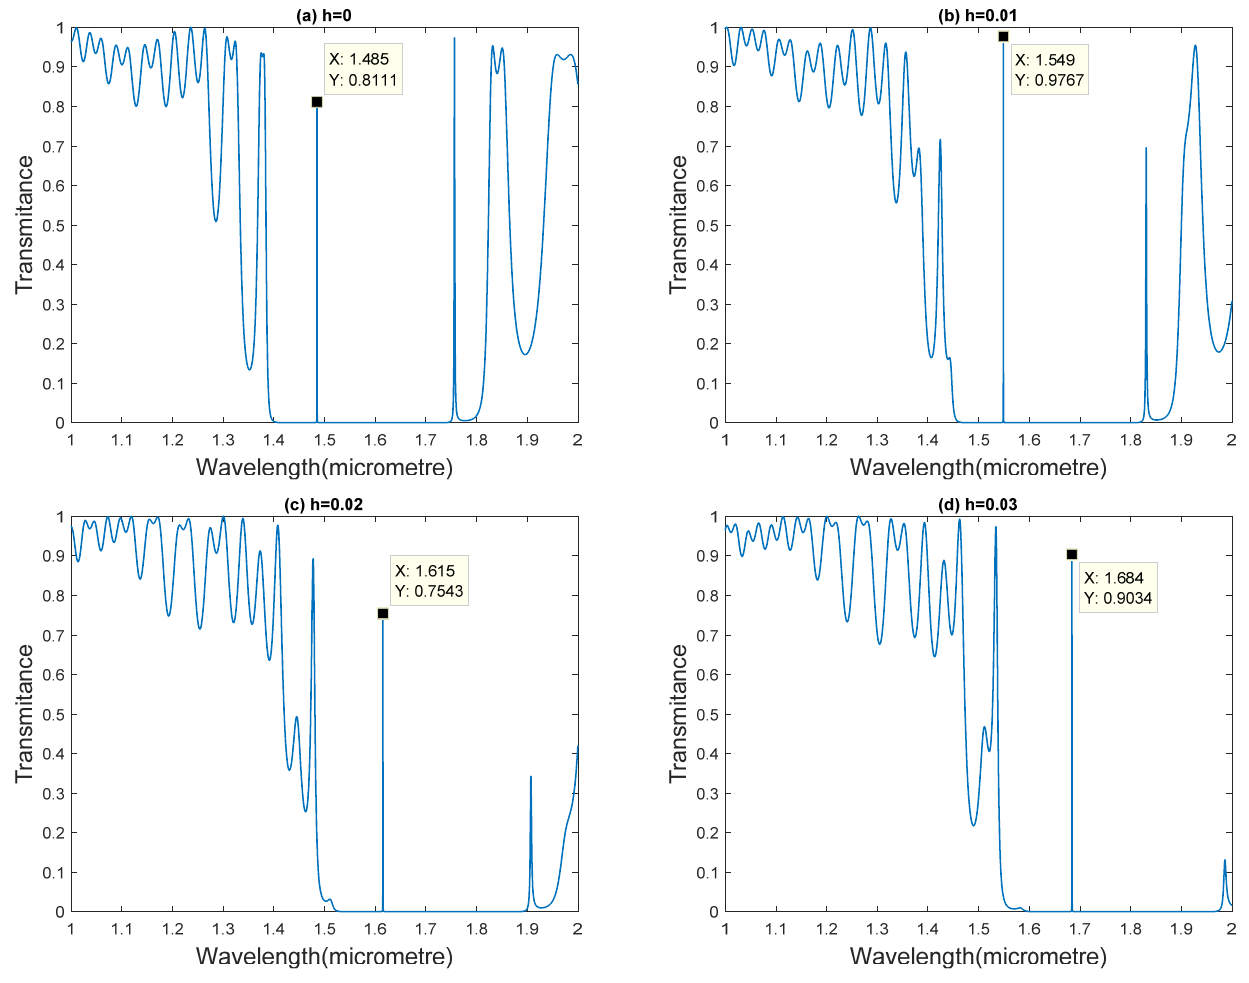
Figure 4. Variation of the transmittance peak intensity as a function of the deformation degree ( h ) for a photonic structure with 50 alternated layers of fused silica and TiO 2 and with a middle cavity filled with seawater of 50% salinity and at room temperature, ( a ) h = 0, ( b ) h = 0.01, ( c ) h = 0.02, ( d ) h = 0.03.